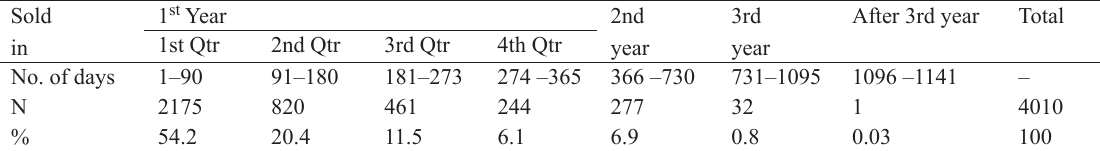
Table 4. Distribution of marketing time